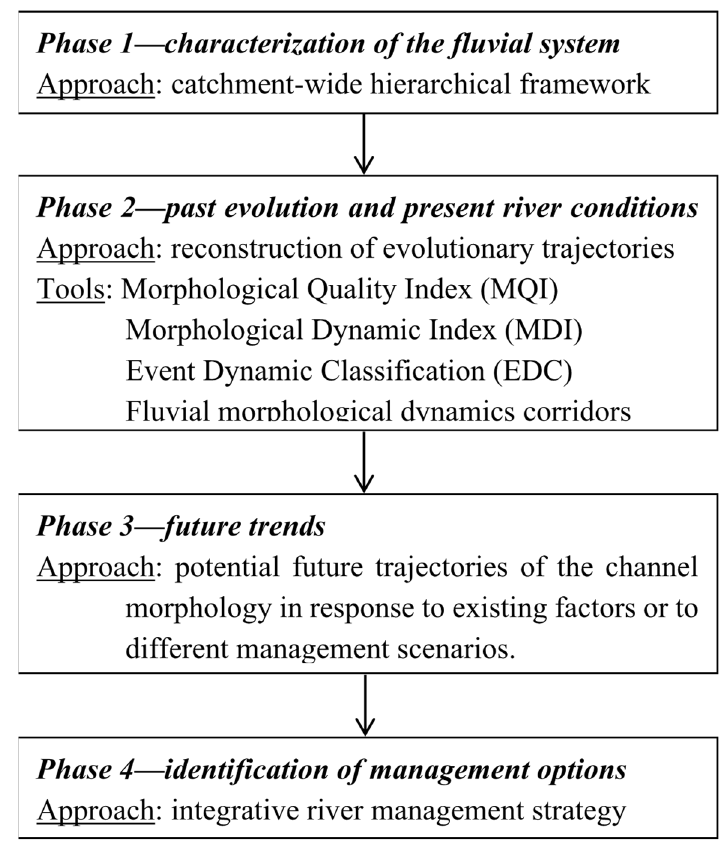
Figure 1. Workflow of the IDRAIM procedure (as modified by [22]) .